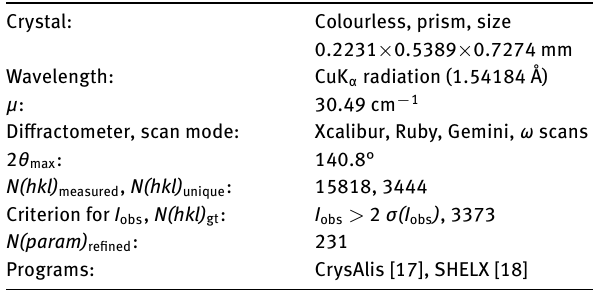
Table 1: Data collection and handling.